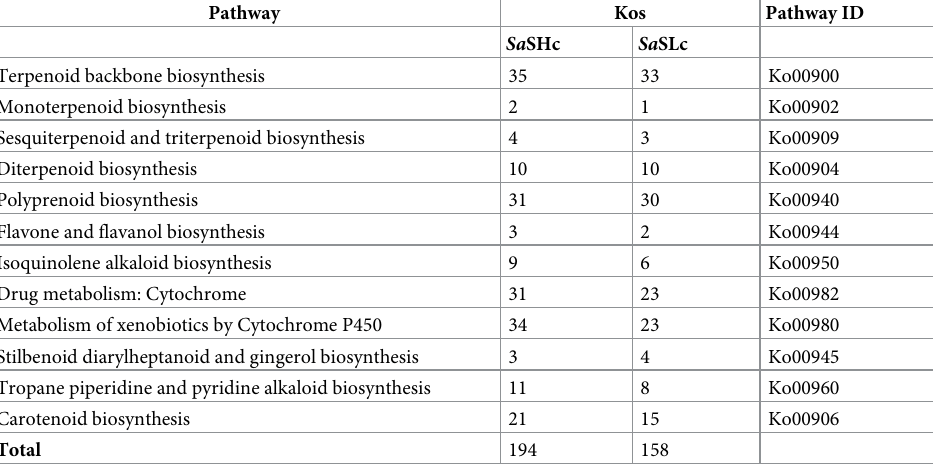
Table 5. Comparative analysis of DEGs involved in secondary metabolite biosynthesis pathway analysis of Kos in high oil ( Sa SHc) and low oil ( Sa SLc) yielding sandalwood ( S . album ). Pathway Kos Pathway ID Sa SHc Sa SLc